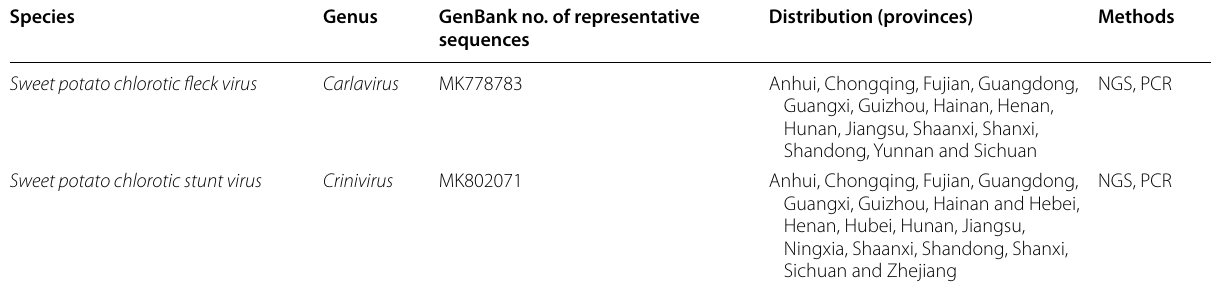
75.8–78.4% and 85.1–87.6%, respectively, with other isolates. Pairwise comparisons of the gene sequences of 10 SPLV isolates obtained revealed nt and deduced aa sequence identities in the range of 82.0–99.4% and 86.9–99.7%, respectively. The nt and aa sequence identities of these 10 isolates with five known isolates of SPLV (HG181, HN76, SC5, Taiwan and (Additional file 1: Table S3). A comparison of genomic sequences of the three SPV2 isolates (gan-17-1, lu-17-14 and su-17-8) that we obtained and 10 known SPV2 iso-